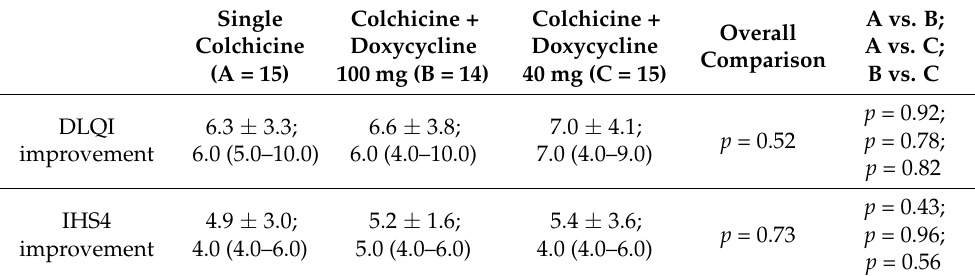
Table 3. Comparison of score improvements (before and after treatment) among the different colchicine treatment